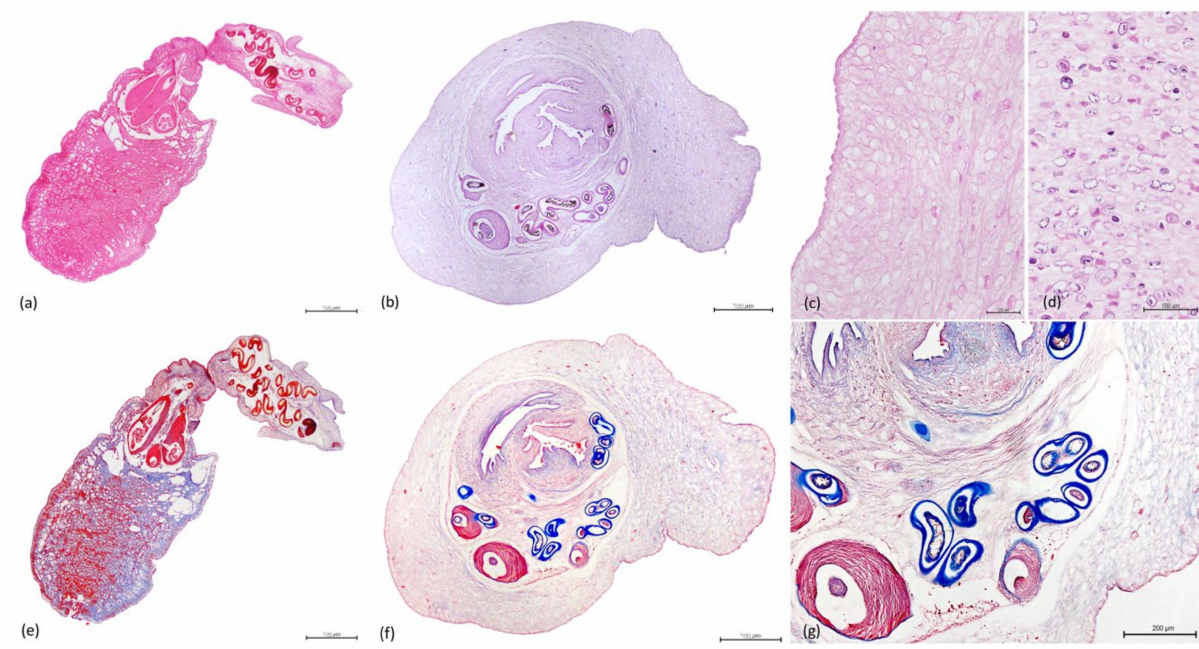
Figure 8. Histology, HE stain. Trypanorhyncha plerocerci. ( a ) Longitudinal section, eosinophilic tegument, lacy, fibrillar, eosinophilic parenchyma and scolex with muscular bulbs and armed tentacles (scale bar = 500 µ m). ( b ) Transversal section, muscular bulbs and armed tentacles (scale bar = 500 µ m). ( c ) Eosinophilic tegument (scale bar = 100 µ m). ( d ) Parenchyma, numerous, basophilic to clear, round calcareous corpuscles (scale bar = 100 µ m). Histology, MT stain. ( e ) Longitudinal section, tentacle sheaths and muscular bulbs staining red with MT (scale bar = 500 µ m). ( f ) Transversal section, muscular bulbs and armed tentacles (scale bar = 500 µ m). ( g ) Detail of the muscular bulbs and hooks (scale bar = 200 µ